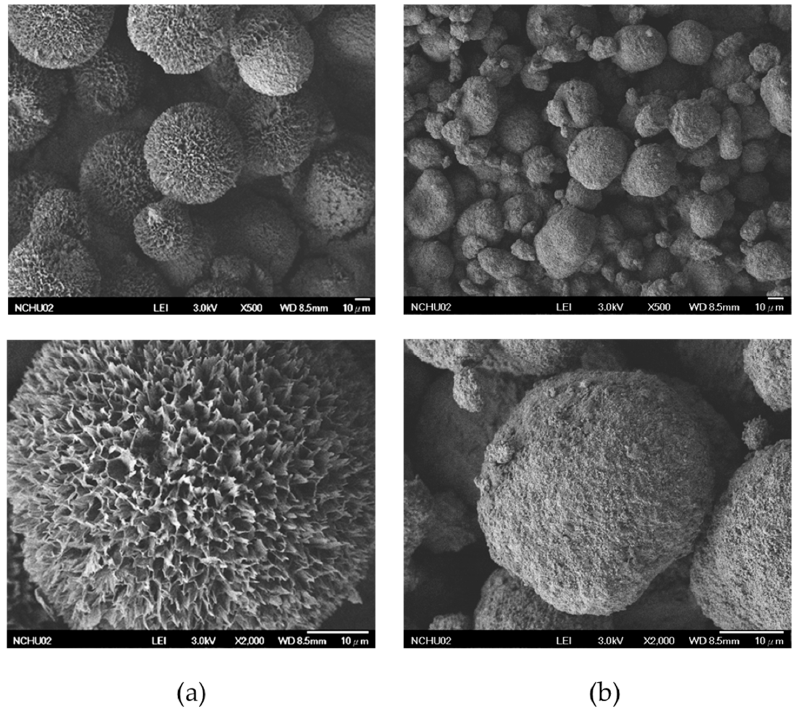
Figure 1 . FE-SEM micrographs of ( a ) the synthesized HAp–gelatin porous composite microspheres and ( b ) the commercial HAp from Sigma-Aldrich. Table 1. Ca content, P content, and Ca/P atomic ratio of the commercial HAp and the prepared